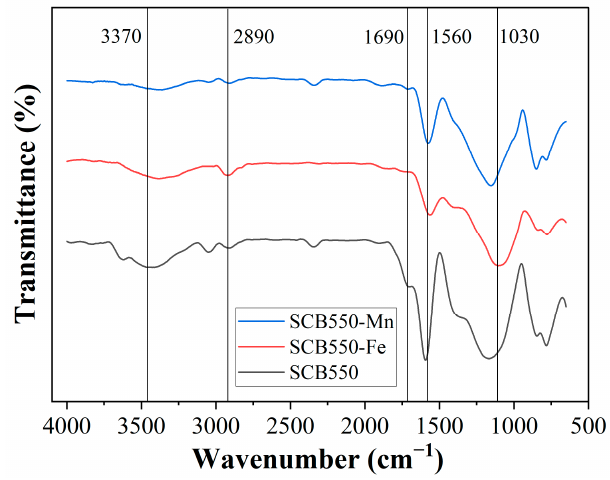
Figure 3. FTIR spectra of catalytic biochar SCB550-Fe and SCB550-Mn in contrast with pristine biochar SCB550.